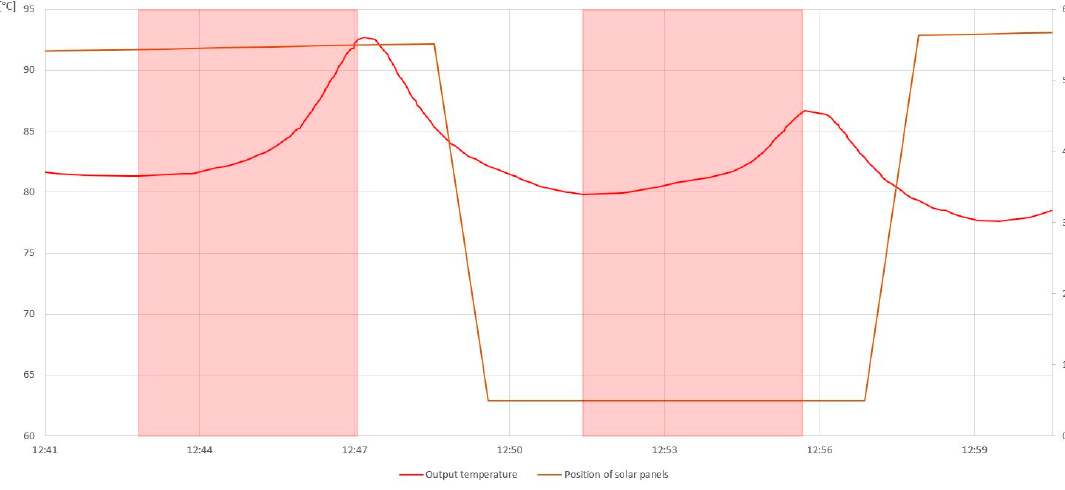
Figure 16. Simulation of circulation pump failure with and without tilting the panel to the end position.